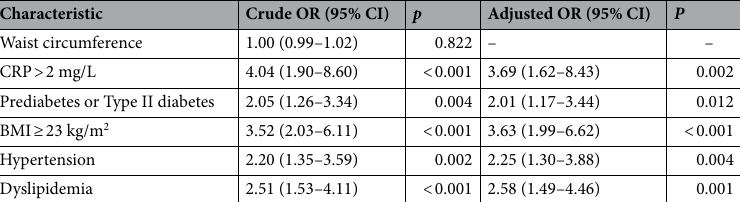
Table 2. Association between metabolic traits and MAFLD-HCC on univariate and multivariate logistic regression analysis. FIB-4 fibrosis-4, BMI body mass index.